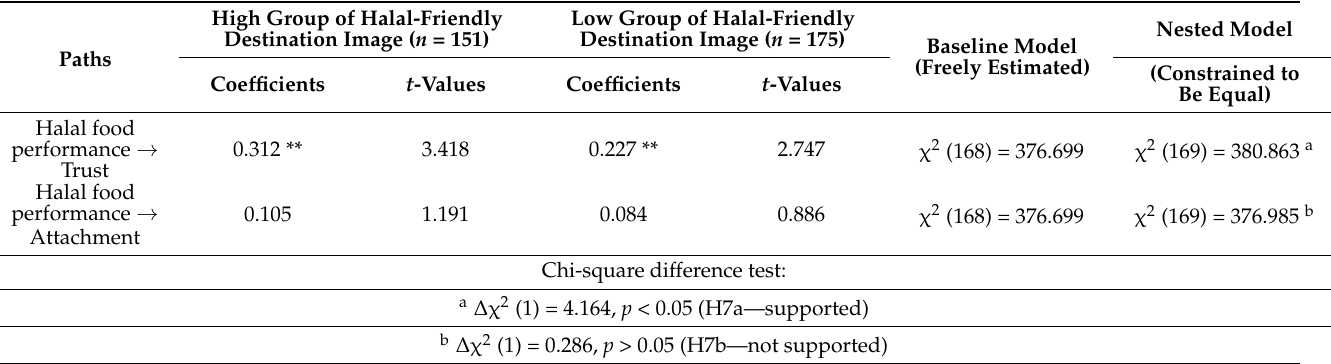
Table 4. Baseline and invariance model assessment